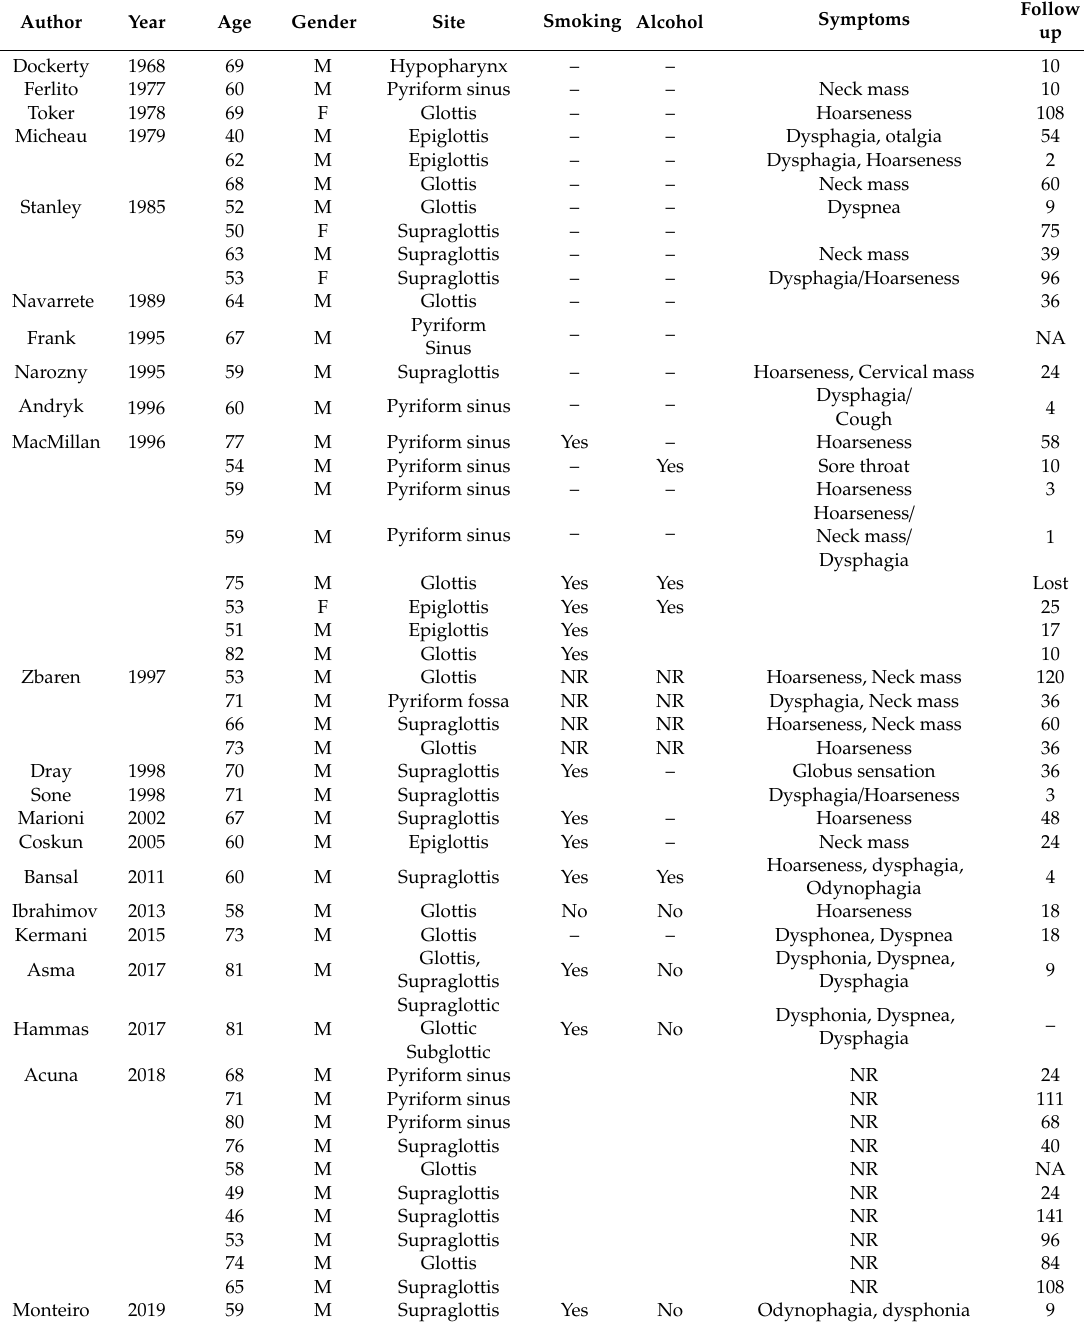
Table 2. Demographics and clinical characteristics of the studies included in the